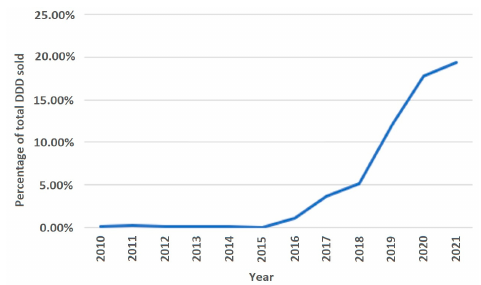
Figure 5. Statin sales in polypills of total statin sales.